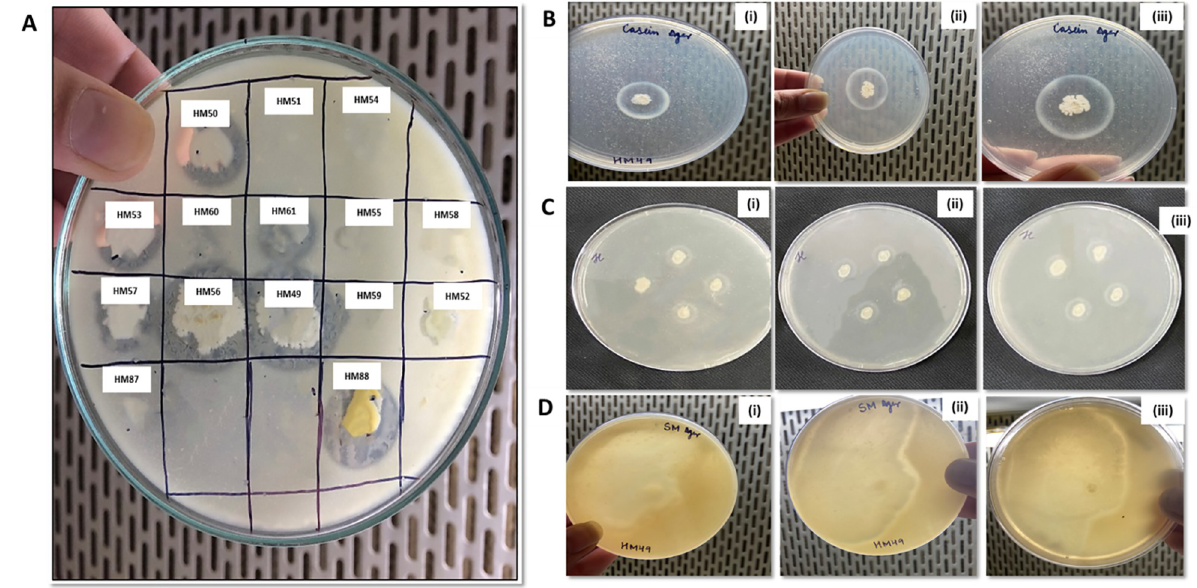
Fig 1. Screening of bacteria for its proteolytic activity- preliminary screening of isolated bacteria for their proteolytic activity on skim-milk agar (A); primary screening of Bacillus sp. HM49 on casein (B), gelatin (C) and skimmed milk (D) agar media at a temperature of 20 ˚C (pH 8.0) after (i) 24 h, (ii) 48 h, and (iii) 72 h incubation